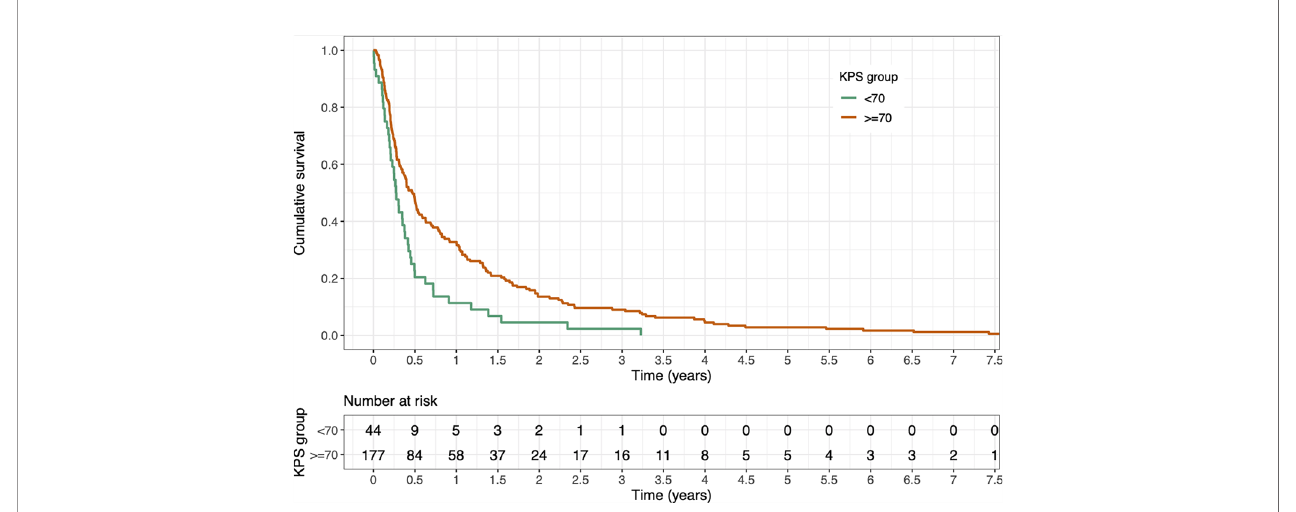
FIGURE 1 | Kaplan-Meier estimate of overall survival (OS) after fi rst radiotherapy strati fi ed by Karnofsky Performance Score (KPS) <70 vs. ≥ 70. OS was signi fi cantly better for patients with a KPS of ≥ 70% (p < 0.001, log-rank